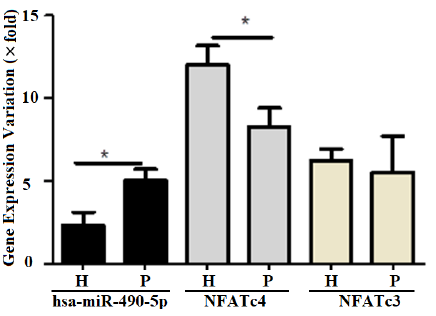
Fig. 2. The gene expression of hsa-miR-490-5p and NFATc3 , NFATc4